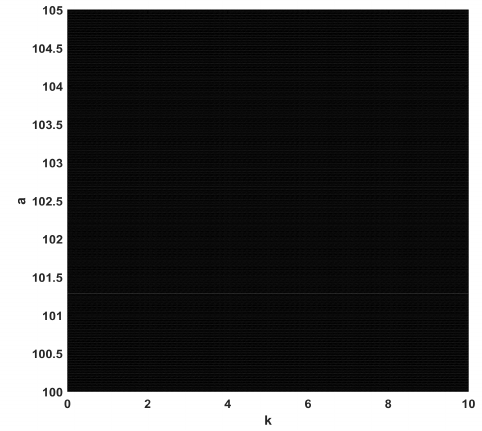
Figure 17. Diagram depicting the parameter pairs ( k , a ) of (31) that yield chaotic behavior, N = 1. Black regions depict chaos, while white regions are non-chaotic. As with previous maps, no periodic regions appear. The simulation stepsize for each parameter was set to